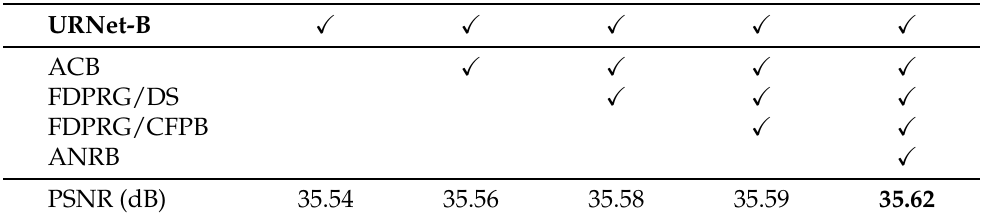
Table 1. Ablation experiment results of different blocks on DIV2K val. Bold indicates the best performance ( × 2